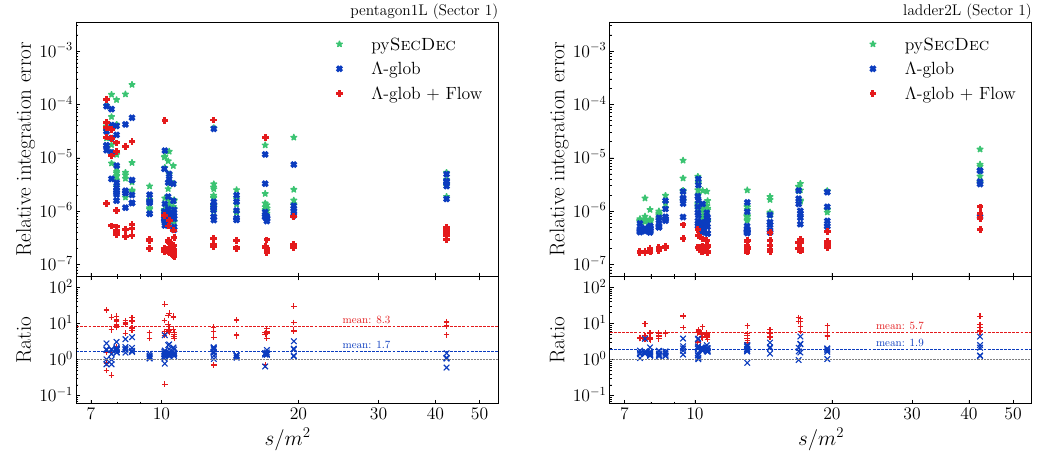
Figure 9: Relative integration error for sector one of the pentagon1L (left) and lad- der2L (right) integrals using the standard pyS EC D EC algorithm (green), the Λ -glob algorithm (blue) and Λ -glob with additional normalizing flow (red). The lower panel shows the ratios to the standard